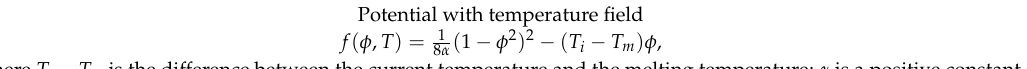
Potential with temperature